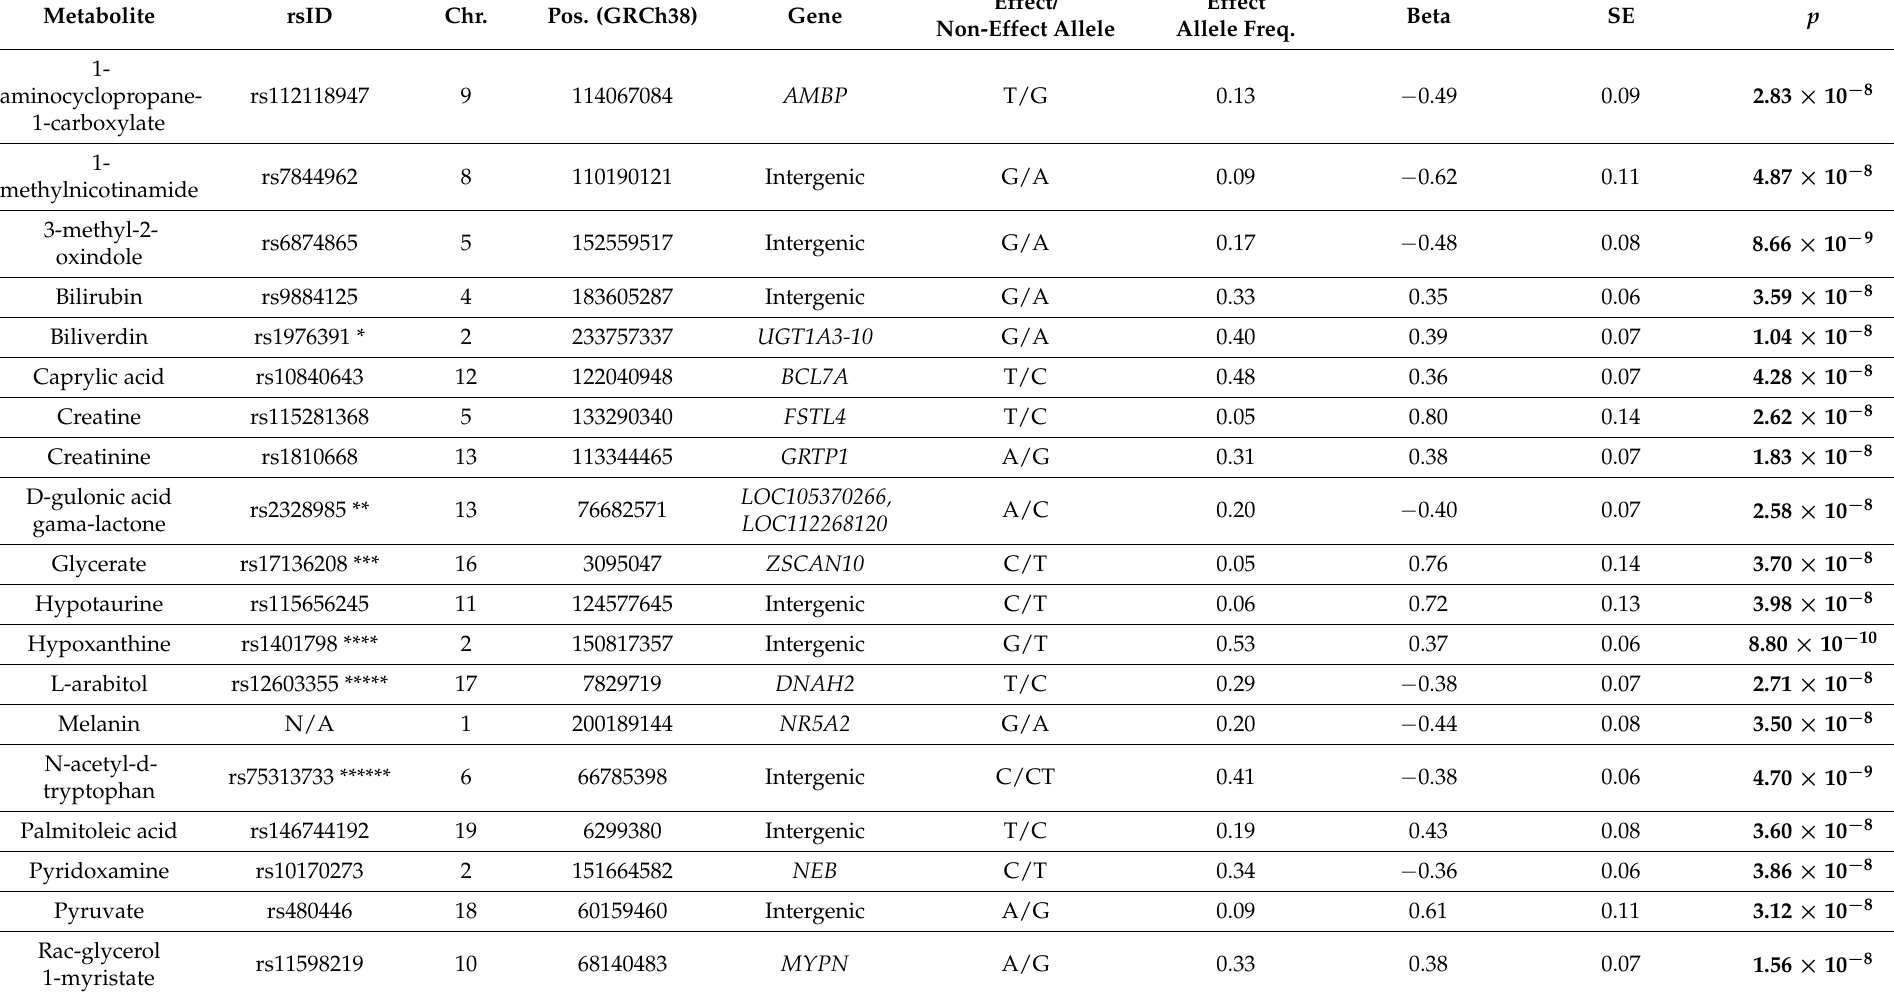
Table 4. Genetic associations with metabolites identified in GWAS ( p < 5 × 10 − 8